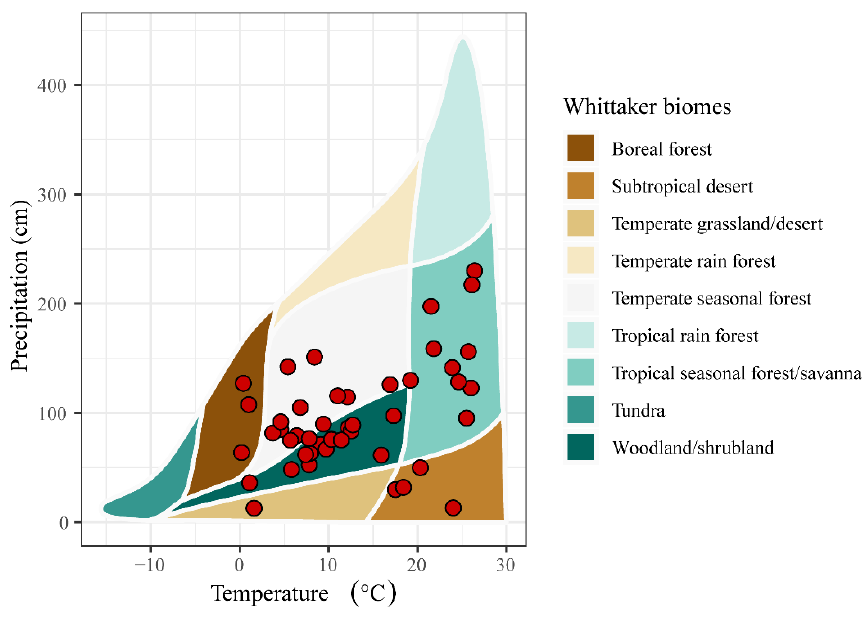
Figure 2. Environmental locations of the 39 studies across Whittaker’s